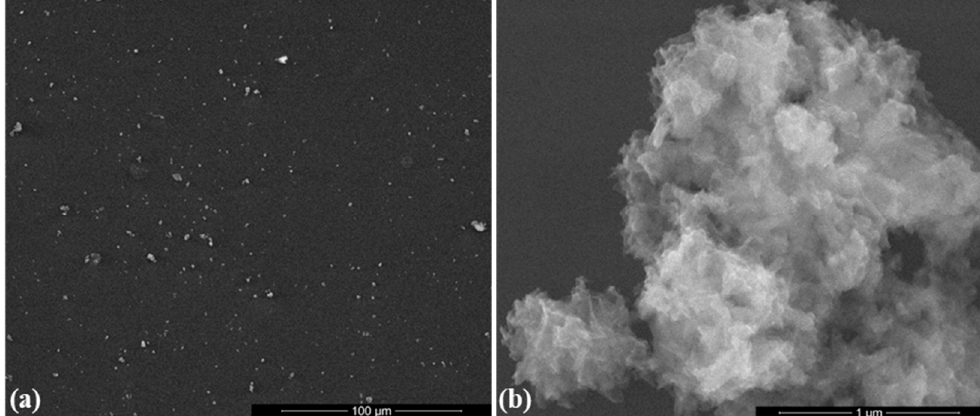
Figure 5. SEM images of HAp/KAN/FGF2 coatings obtained at 300 mJ/cm 2 laser fluence: ( a ) low magnification and ( b ) high magnification.